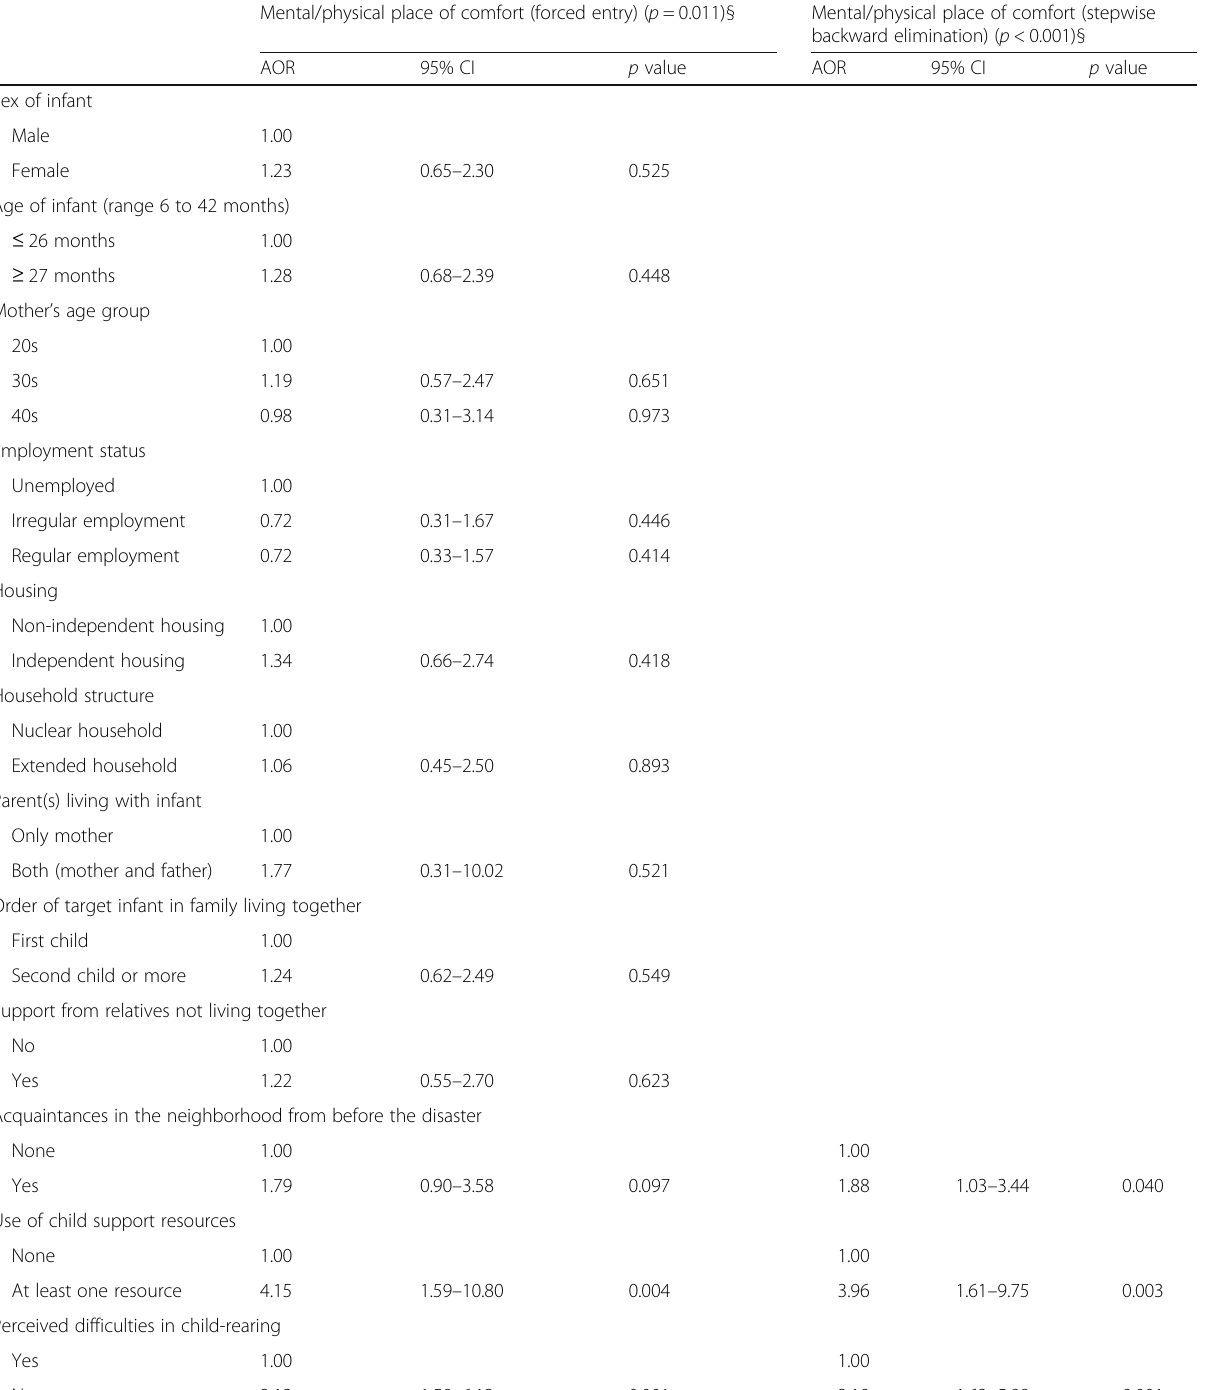
Table 4 Factors related to obtainment of social support by mental/physical place of comfort category ( n = 215) Mental/physical place of comfort (forced entry) ( p =